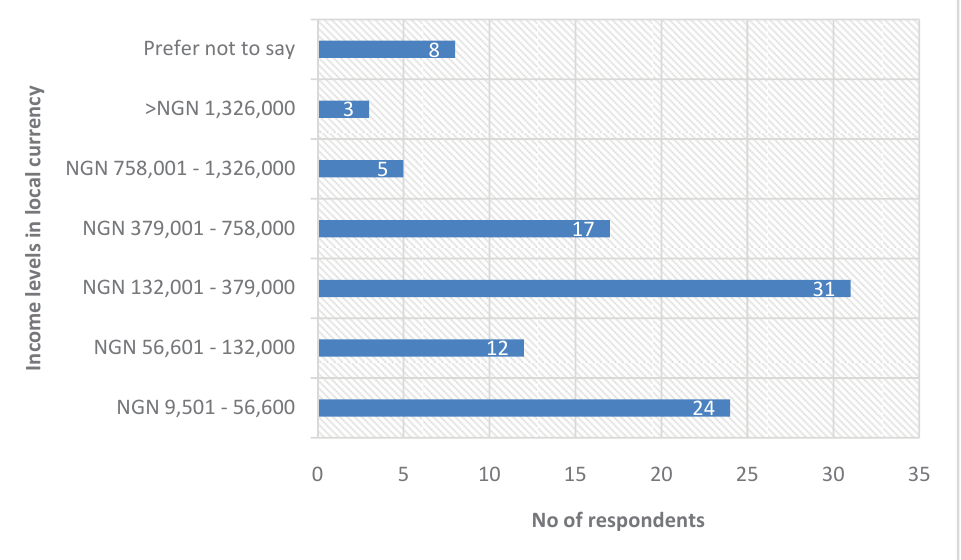
Fig. 2. Monthly income per consumer